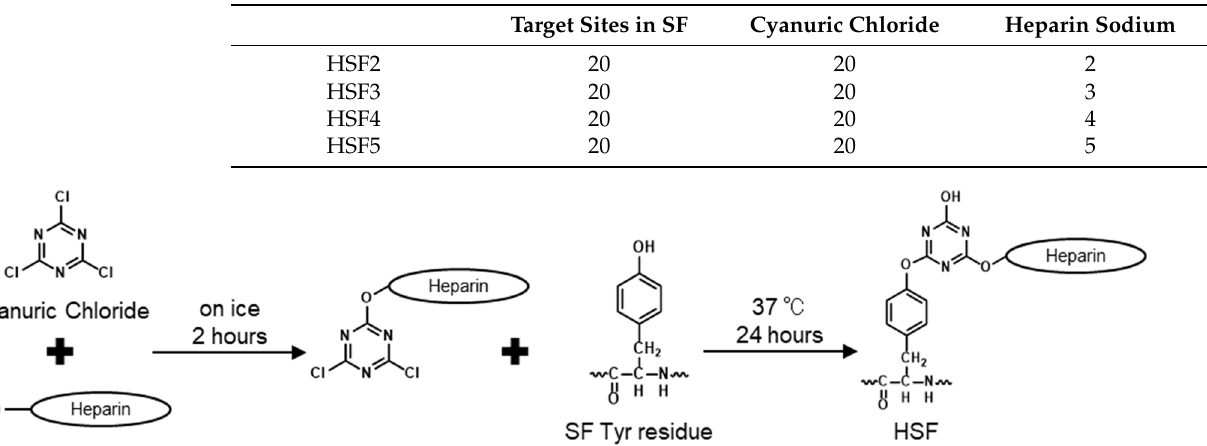
Figure 1. A schematic diagram of the chemical modification reaction of SF with cyanuric chloride– activated heparin.